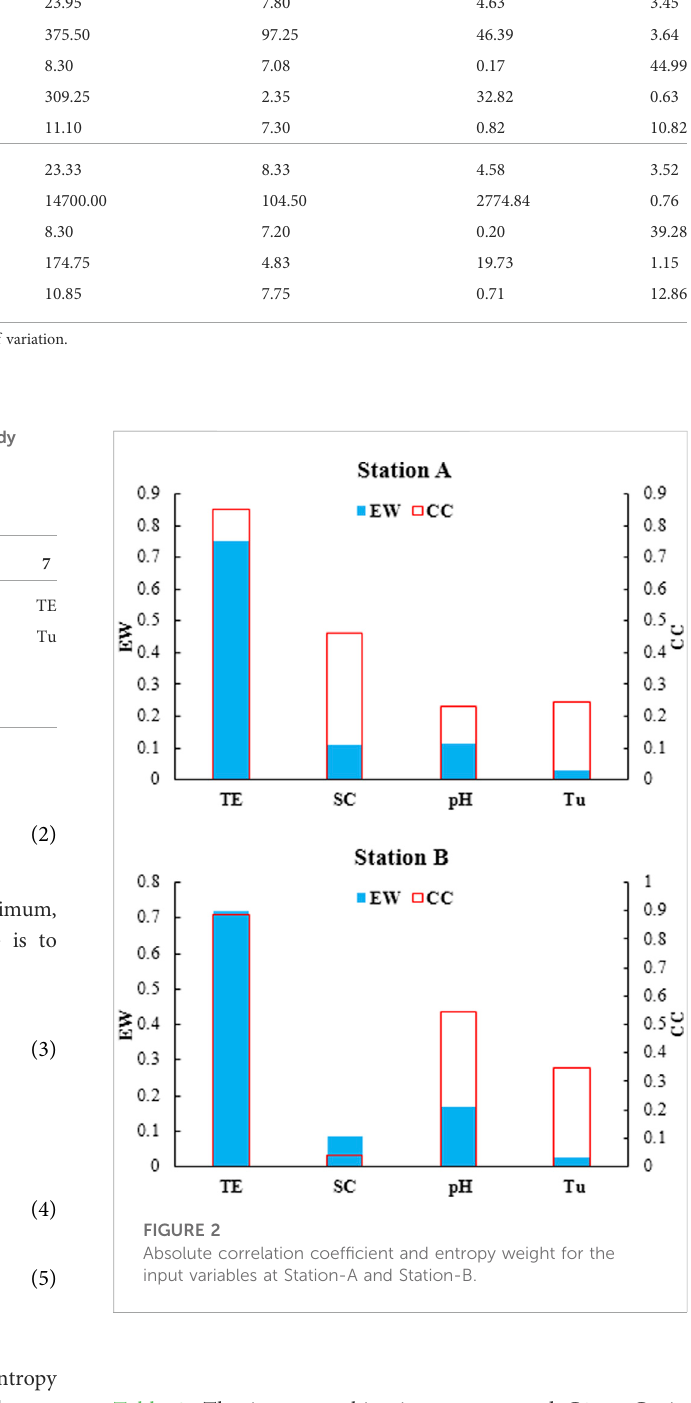
Table 2. The input combinations are termed C1 to C7 in Table 2. The comparison of model performance for different